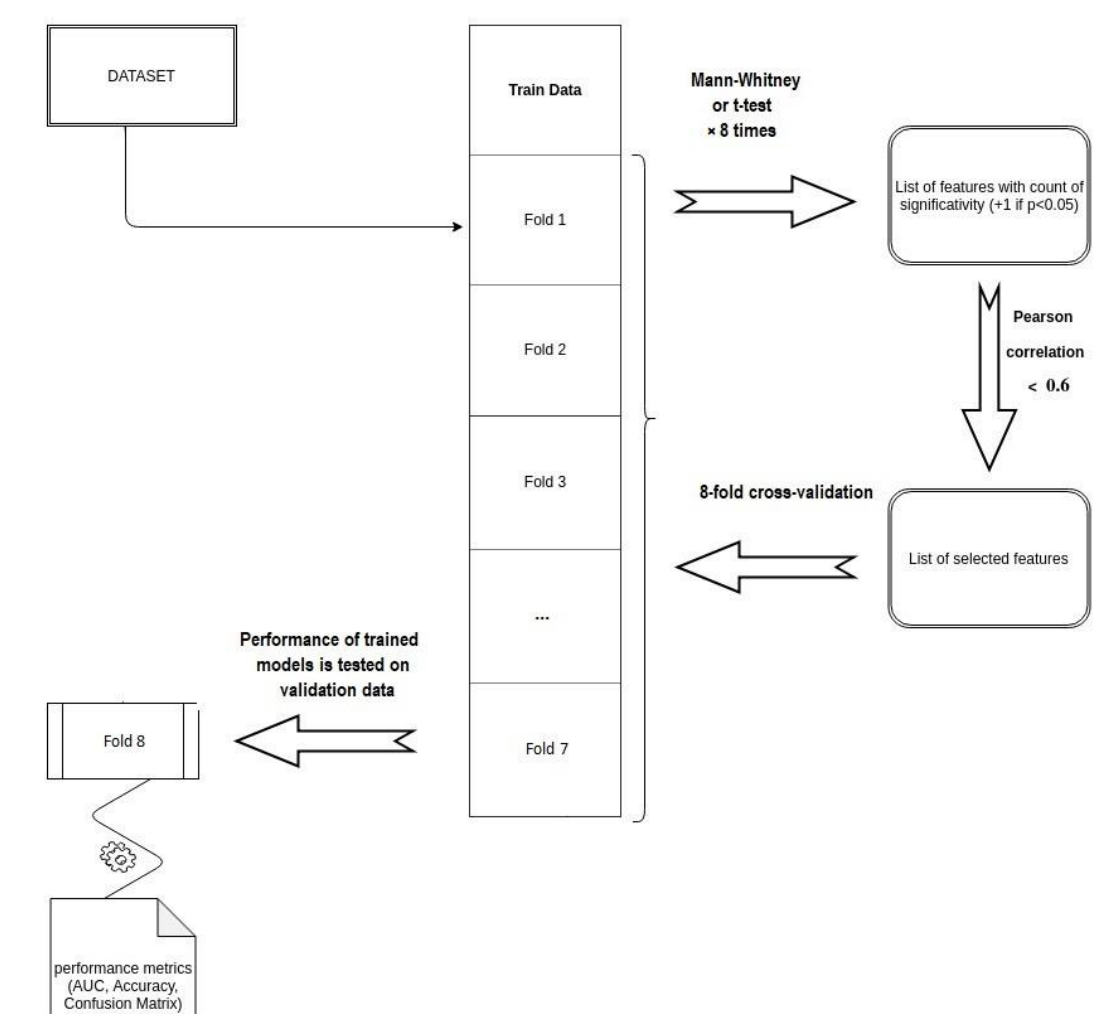
Figure 1. Scheme of the workflow used for features and model selection.